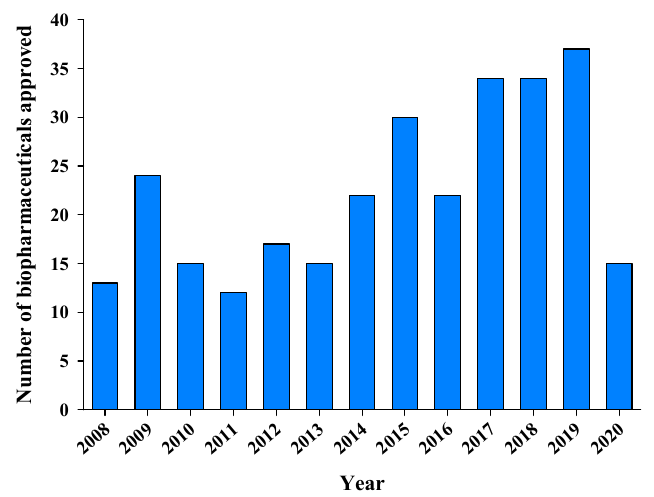
Figure 1. The number of biopharmaceuticals approved by the FDA from 2008 to 2020 (http://www.biopharma.com/approvals).